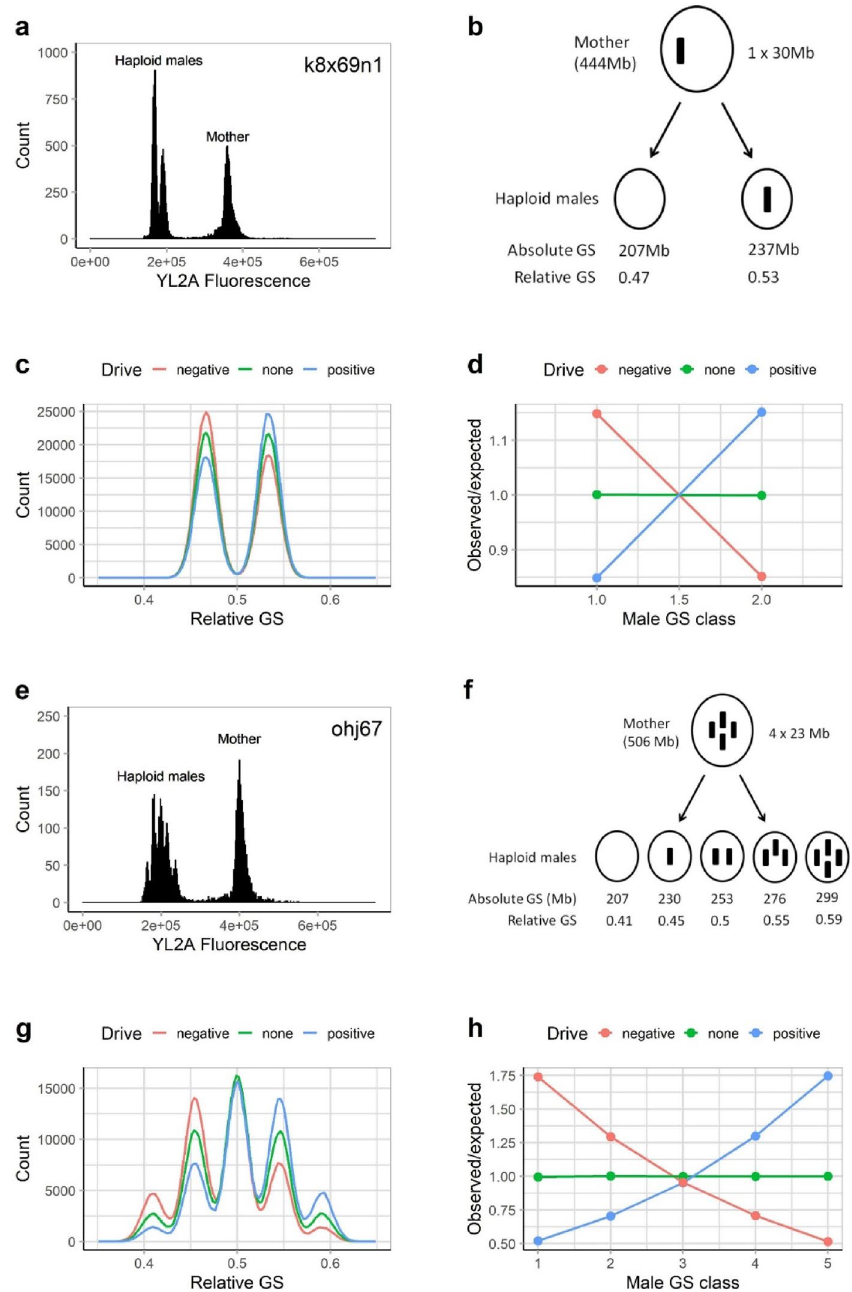
Figure 2. Principle of inferring meiotic transmission patterns from the genome size distributions of haploid rotifer males. The first four panels ( a – d) show a rotifer clone with one ISE (i.e., two corresponding male GS classes). The last four panels ( e – h) show a clone with four ISEs (i.e., five corresponding male GS classes). a , e Example of flow cytometry data. b , f Conceptual model of ISE meiotic segregation. c , g Theoretically predicted GS distributions of males (relative to the female GS) under meiotic drive, meiotic drag, or in the absence of meiotic drive. d , h Theoretically predicted O/E ratios (observed vs. expected frequencies of different male GS classes) under drive, drag, or on absence of drive. O/E values of > 1 indicate over-representation of a GS class (relative to the frequency expected from unbiased